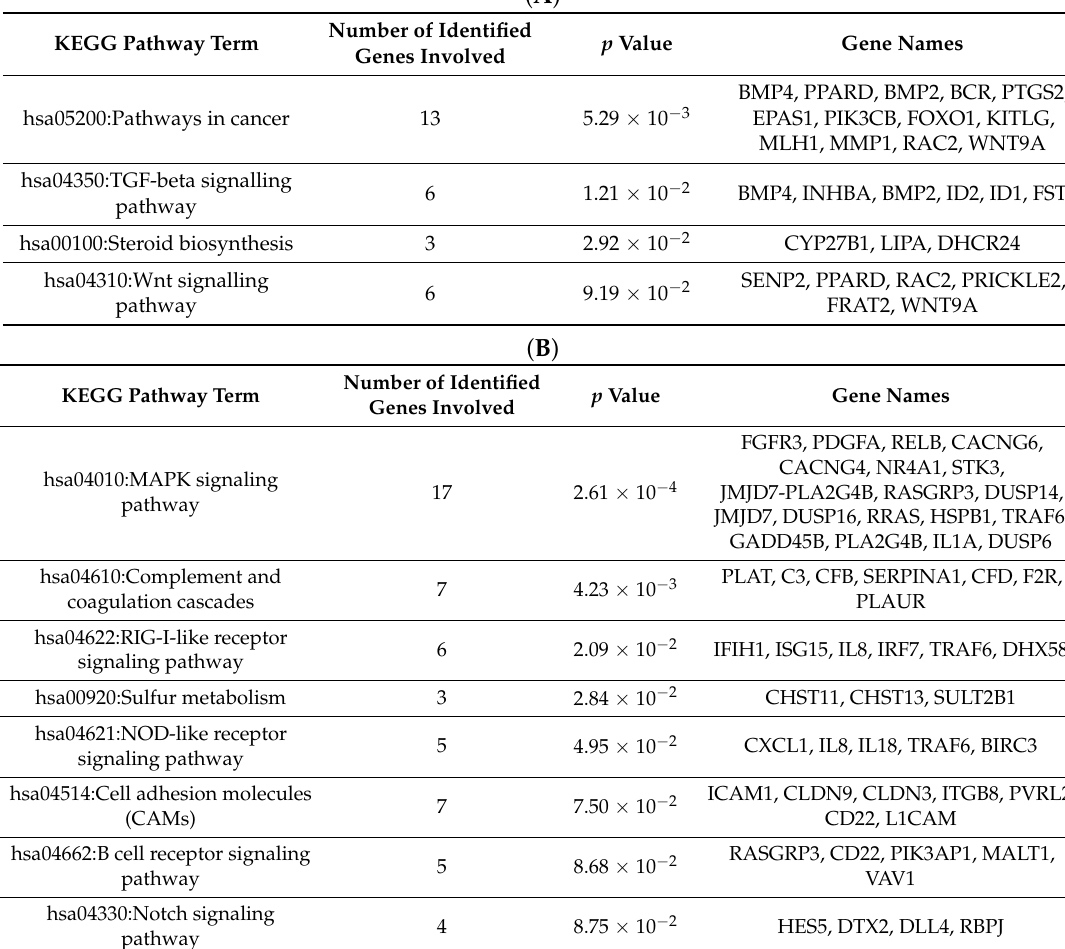
Table 1. Kyoto Encyclopaedia of Genes and Genomes (KEGG) pathway analysis identifies significant pathway differences in OE33 Cis P versus OE33 Cis R cells. ( A ) KEGG pathway analysis of gene expression data identified four pathways that were significantly upregulated in OE33 Cis R cells compared to OE33 Cis P cells. ( B ) KEGG pathway analysis of gene expression data identified eight pathways that were significantly downregulated in OE33 Cis R cells compared to OE33 Cis P